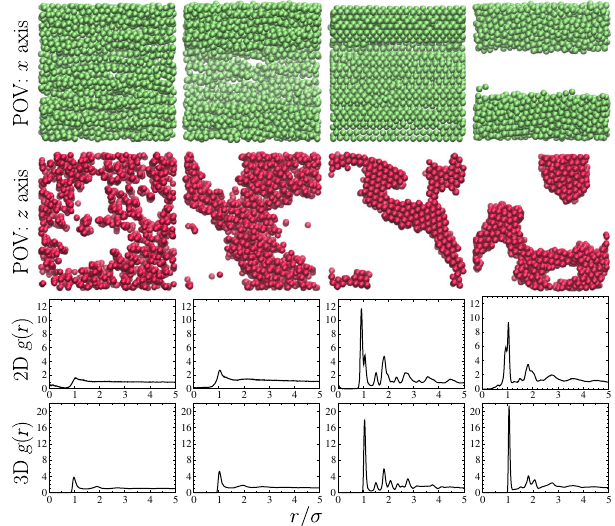
FIG. 10. Equilibrium configurations of the colloidal system with μ ¼ 2 , ϕ ¼ 0 . 2 , and their associated 2D and 3D radial distribution functions. From left to right, these are the state points with ϵ ¼ 0 . 25 , 0.5, 1.5, and 3. POV indicates point of view along a particular